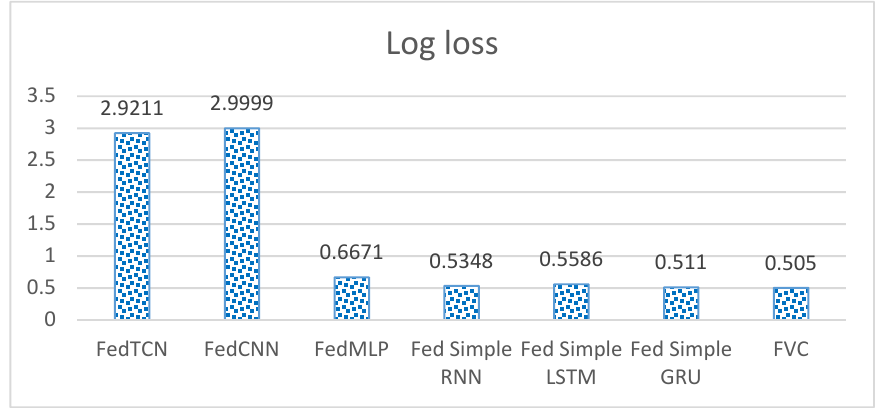
Figure 7. Comparison of previous literature with FVC in terms of log loss.